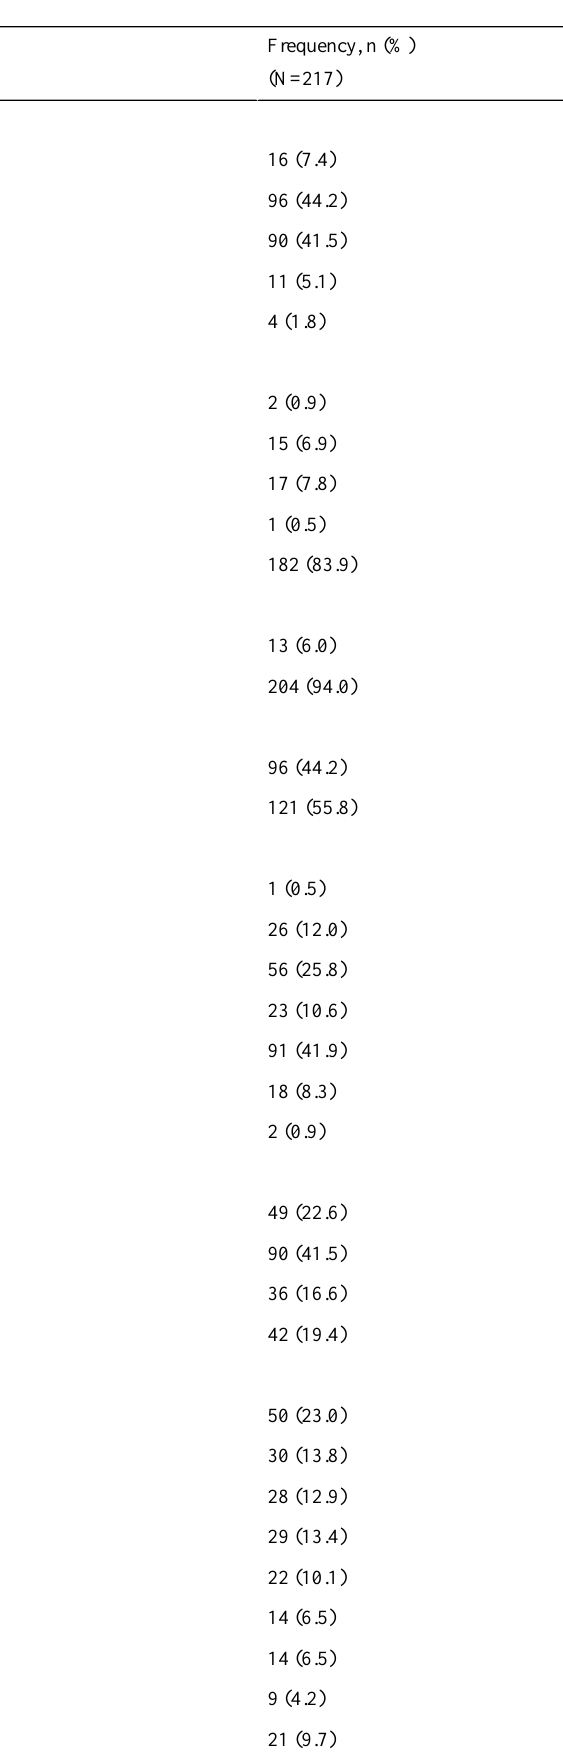
Table 1. Summary of participant